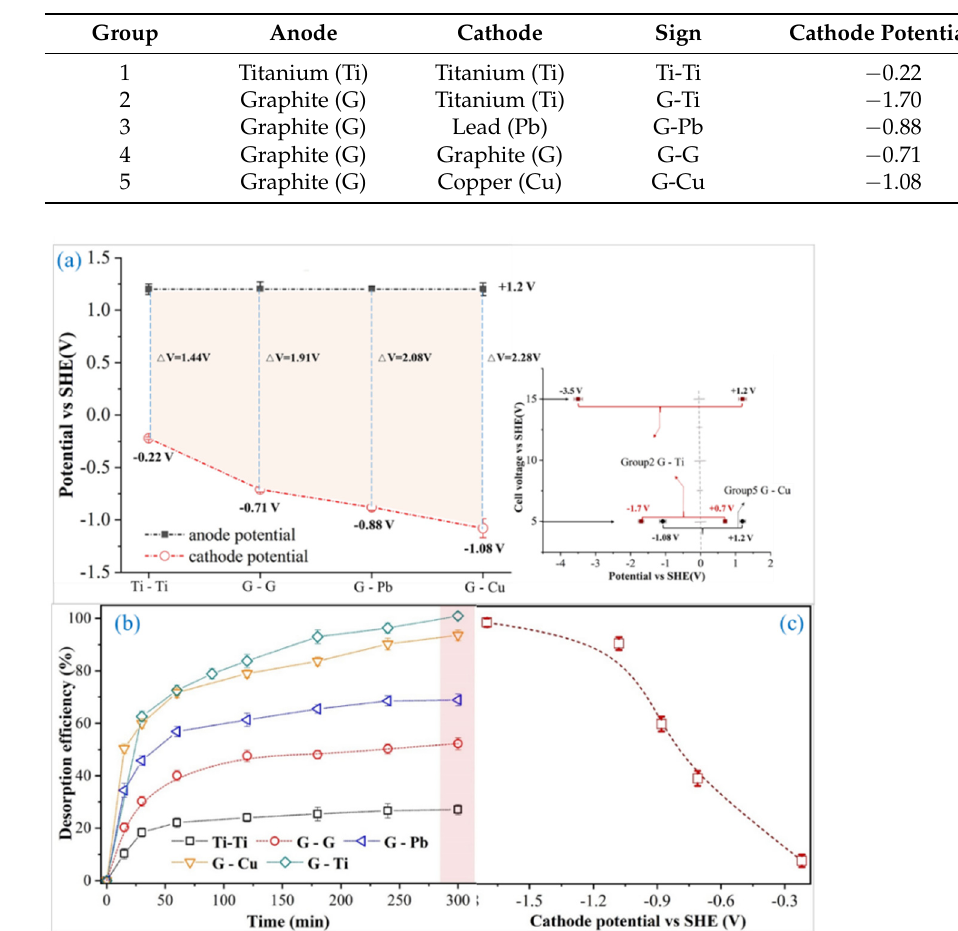
Figure 3. Effect of electrode configuration. ( a ) The cathode potential development of different elec- trode types. ( b ) The desorption efficiency of Cl − using different electrode types. ( c ) The corresponding cathode potential (pink streak).